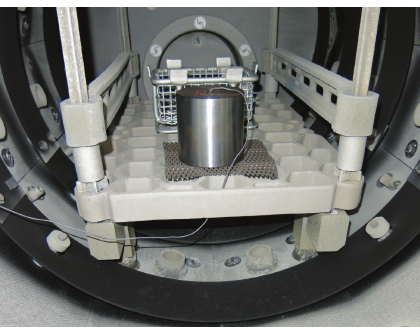
Figure 4: Axisymmetric finite element model of a cylinder using quadrilateral elements with reduced integration. Surface mesh sizes of 250 𝜇 m/65 𝜇 m were used with cylinder diameters of 800 mm/100mm; the cylinder diameters equal their heights. Two differentconstantheattransfercoefficientsareconsideredforthelat- is the circumferential eral (HTC1) and the top surface (HTC2). 𝜎 tang stress component in the middle of the lateral surface at position P1 is the radial stress component on the top surface halfway and 𝜎 rad between the centre and the edge at position P2.